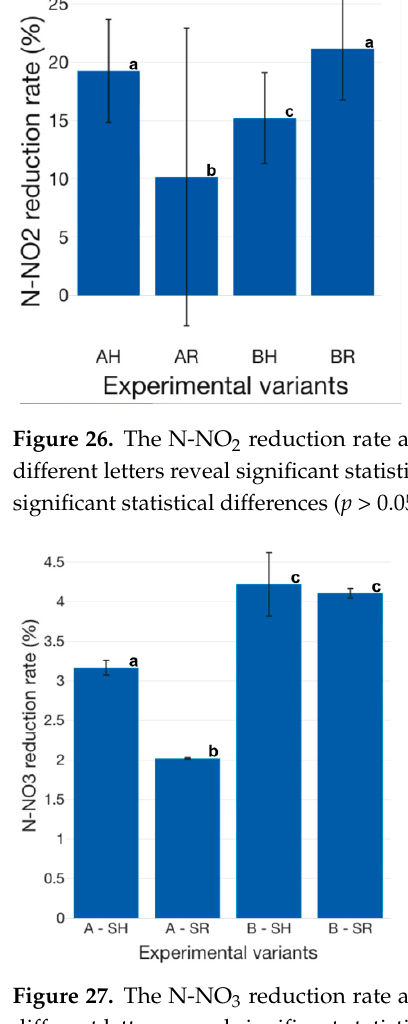
different letters reveal significant statistical differences ( p < 0.05), whereas the same letter reveal not